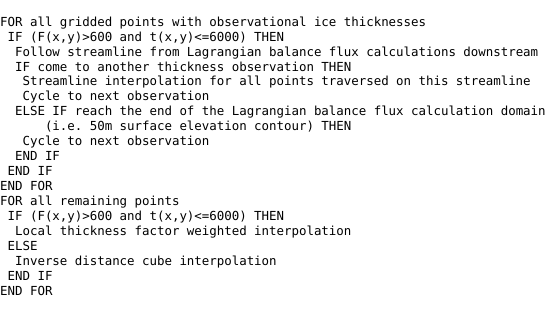
Table 4. Skill and robustness of the pseudo thickness weighted method. The slope and intercept of the linear fit of estimated ice thickness as a function of observed ice thickness is given as a func- tion of the distance to the nearest data point. r 2 is the square of Pearson’s correlation coefficient. cut-off inverse distance cube pseudo thickness method